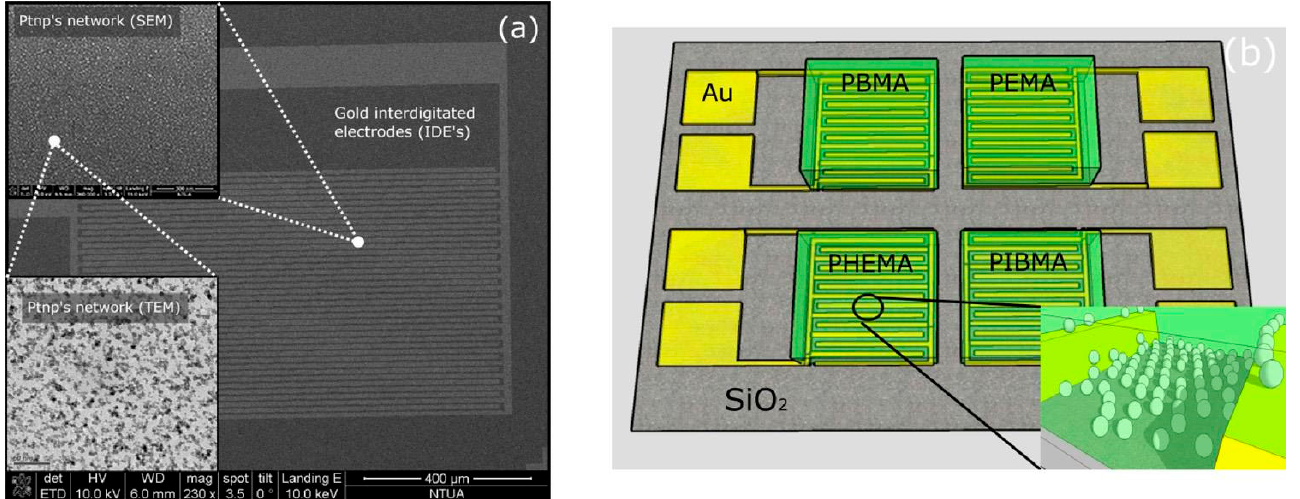
Figure 7. ( a ) SEM image of an array of polymer-coated PtNPs-based chemiresistors, developed for pesticide detection, TEM image of PtNPs layer, with surface coverage 46% and mean nanoparticle diameter of 5 nm; ( b ) schematic representation of the sensor array. Different polymer susceptibility towards water/pesticide vapors leads to a gas-sensing array that is capable of identifying each of the gas-analytes. Reprinted with permission from Ref. [41] Copyright © 2018 Elsevier Ltd.